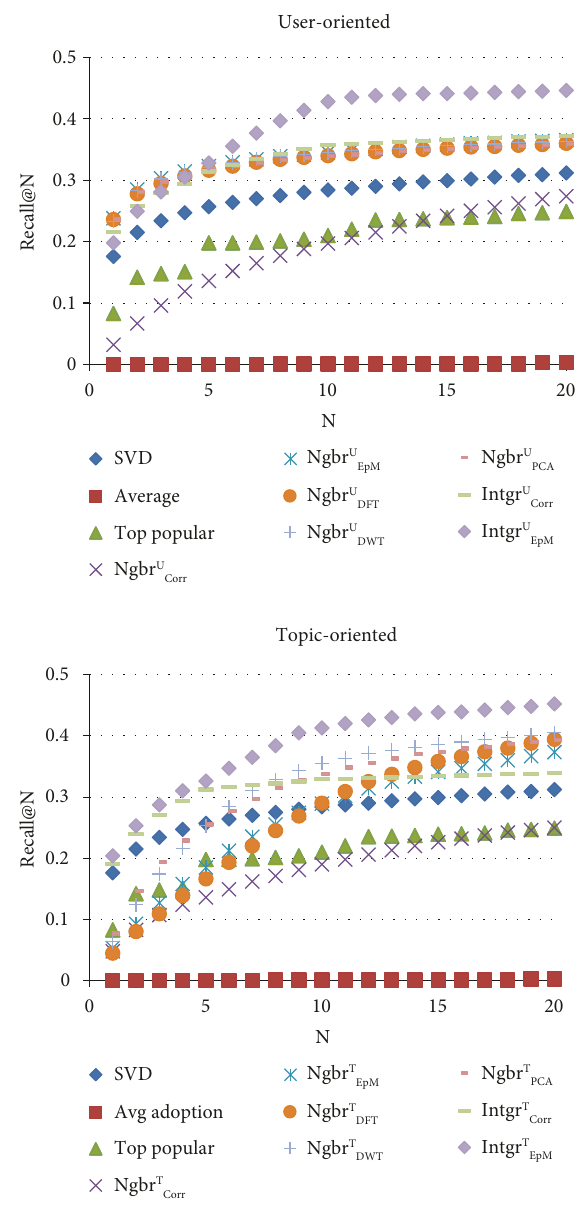
Figure 2: Prediction